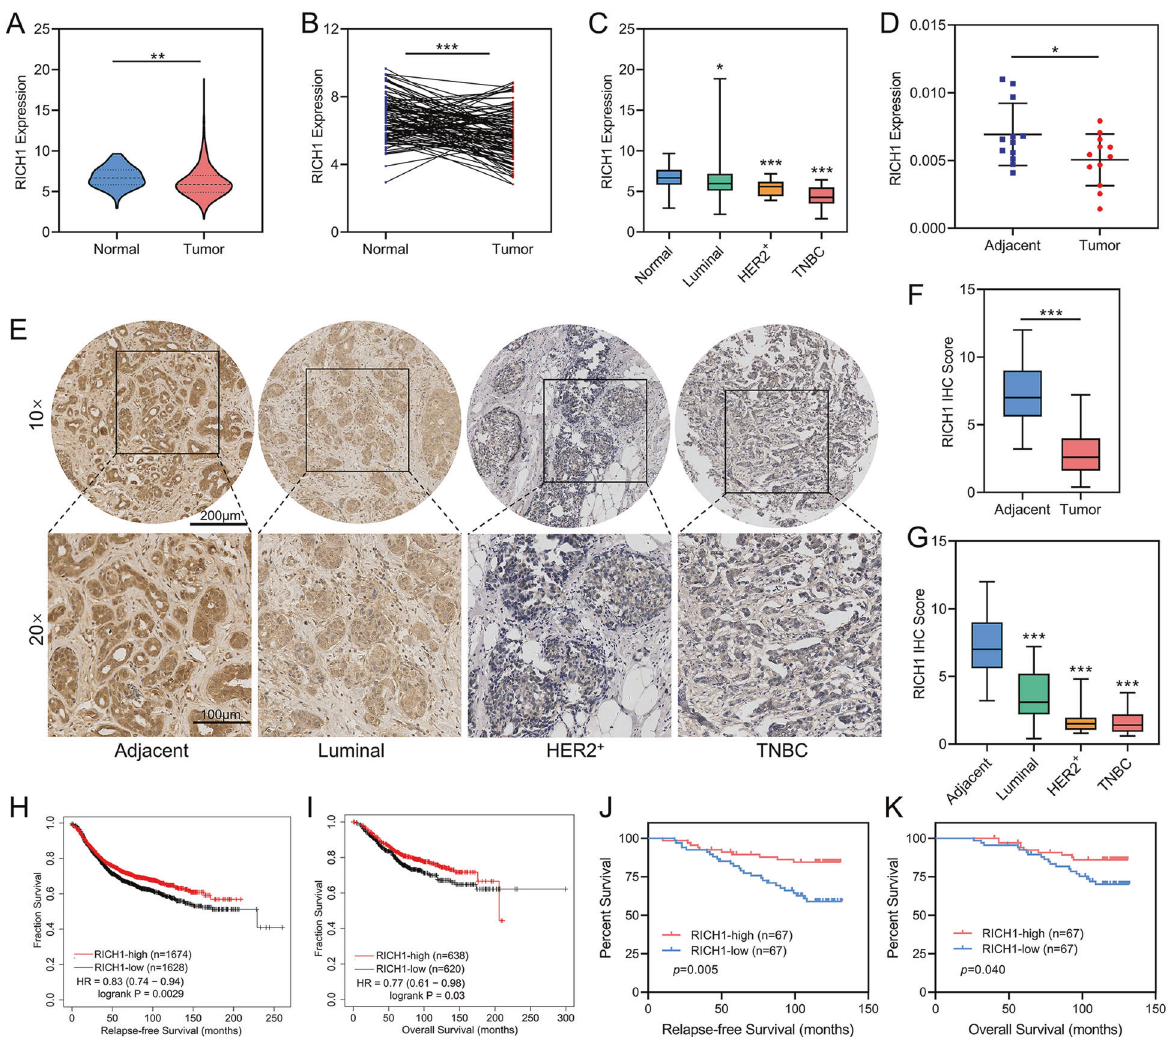
to matched normal tissues obtained from TCGA database. C Box plot of RICH1 mRNA expression in different subtypes of breast cancer and normal tissues obtained from TCGA database. D The mRNA expression of RICH1 in 12 pairs of fresh postoperative breast cancer and adjacent mammary tissues. E Representative images of IHC staining results of RICH1 in breast cancer tissue microarray. F Box plot showing the protein expression levels of RICH1 in 135 breast cancer and 57 adjacent breast tissues. G Box plot showing the protein expression levels of RICH1 in different subtypes of breast cancer and adjacent mammary tissues. H , I Kaplan-Meier survival analysis of RFS and OS of breast cancer patients strati fi ed by RICH1 expression levels according to the online Kaplan-Meier plotter website. J , K Kaplan-Meier survival analysis of RFS and OS of breast cancer patients separated by the median value of RICH1 IHC score. P values in A , C , D , F , and G were calculated using unpaired two- tailed Student ’ s t tests. P value in B was calculated using paired two-tailed Student ’ s t tests. P values in H – K were calculated using log-rank